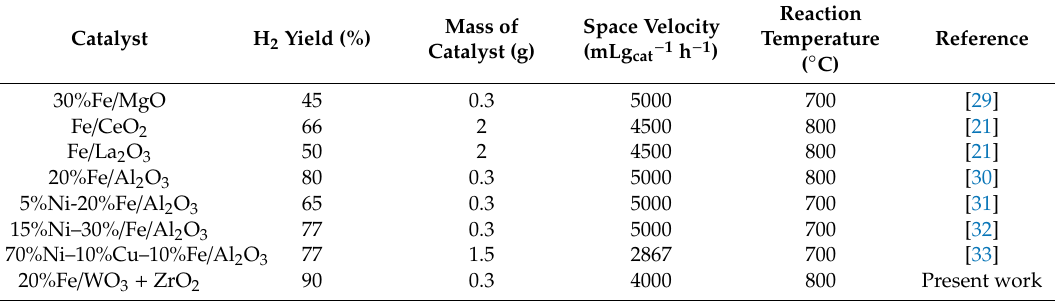
Table 2. Comparison of H 2 yield of past related work with the present study.